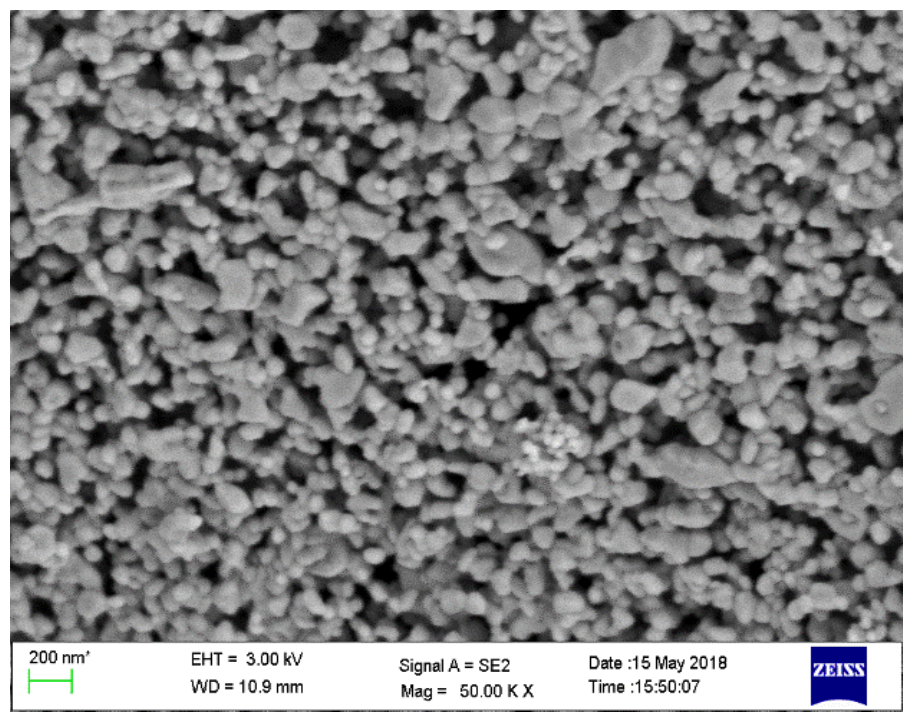
Figure 1. FESEM image of ZnONPs synthesized by onion peel extract at 200 nm. The particle size of synthesized ZnONPs varied from 76.40 ± 16.31 nm, while their morphology was spherical along with a few rod like structures [31]. Haque et al. 2020 reported ZnONPs synthesis from neem leaf extract of size 25–34 nm. The small size was obtained due to the presence of terpenoids present in the neem leaf extract